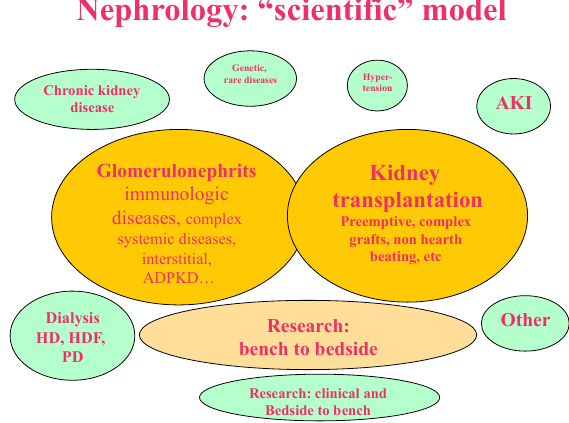
Figure 1. The “scientific” model: the focus is on glomerular diseases, and on kidney transplantation. Basic and bench to bedside research is highly developed.